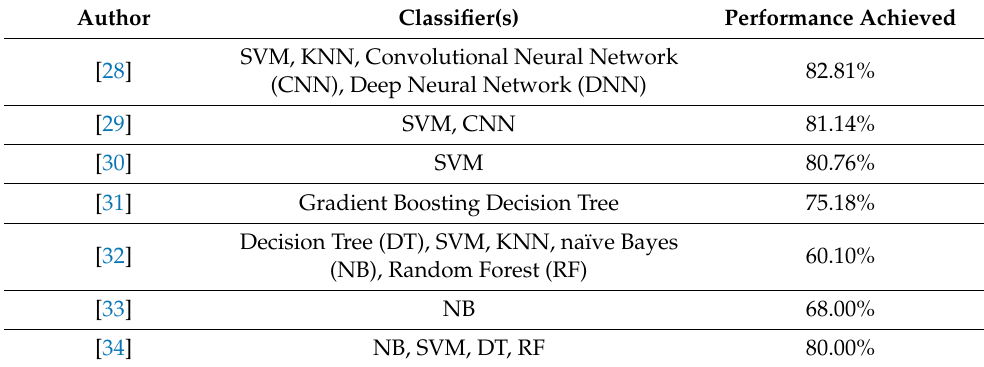
Table 1. Classification performance achieved by prior researchers.